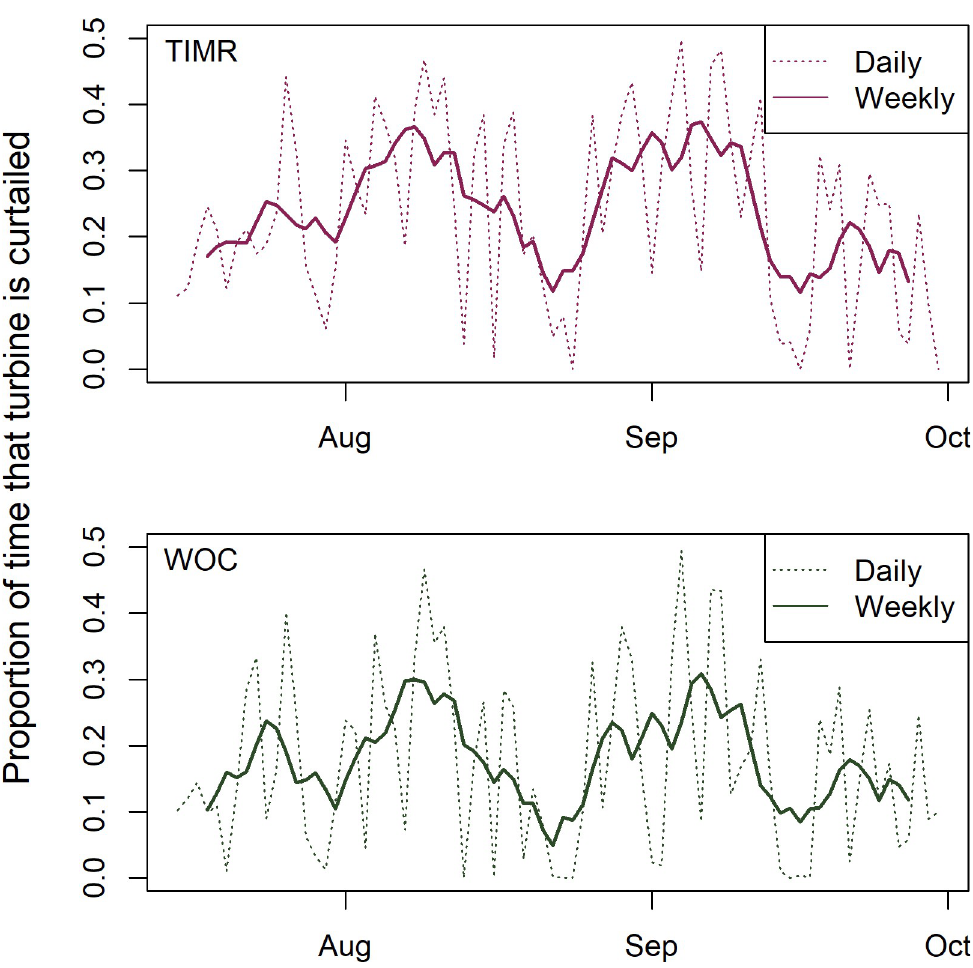
Fig 2. Proportion of time that study turbines were curtailed at the Blue Sky Green Field Wind Energy Facility, Fond du Lac County, Wisconsin, from July 15 − September 30, 2015. Data were collected at 10 Turbine Integrated Mortality Reduction (TIMR) system-curtailed turbines (top panel) and at 10 wind speed-only curtailed (WOC) turbines with a cut- in speed of 4.5 m/s (bottom panel). Control turbines (not shown) were not curtailed at all. Proportion of time curtailed are presented on a nightly basis and on a rolling 7-day average